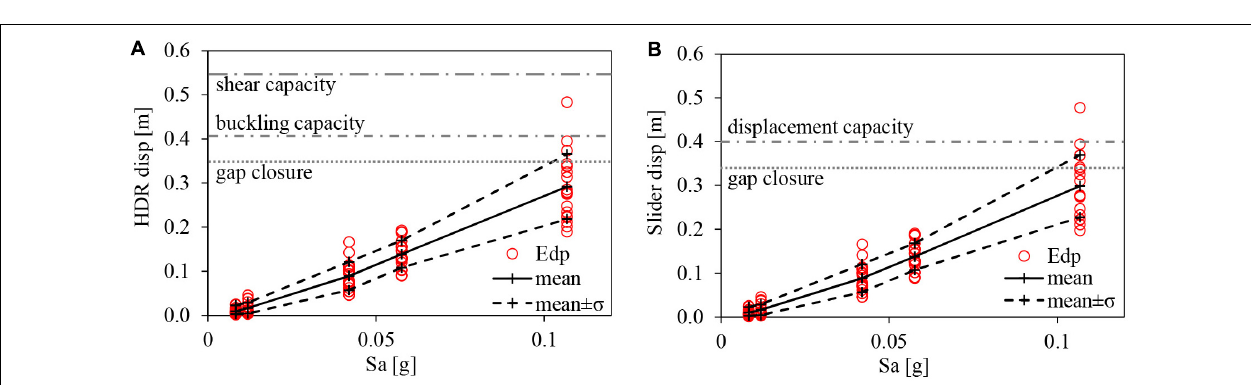
0.5% (typical of dimpled lubricated PTFE sheet on